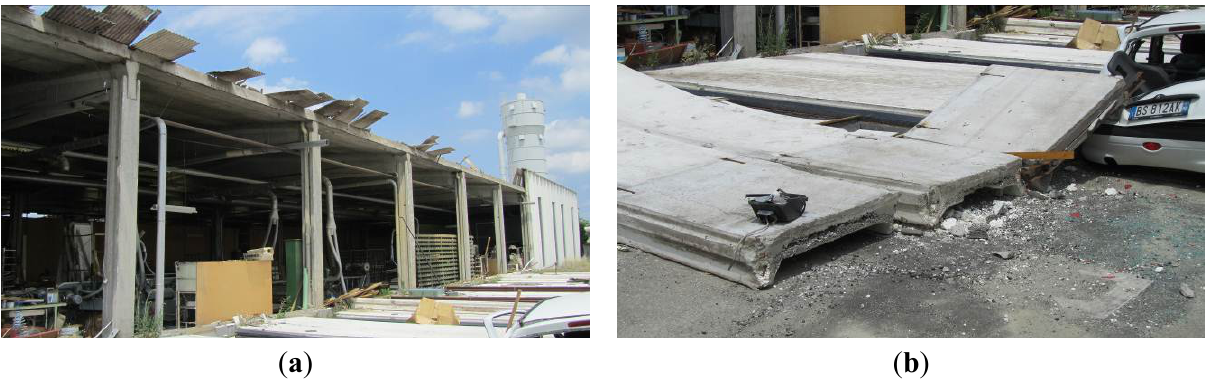
Figure 7. External view of precast reinforced concrete (RC) building with tilted façade panels: ( a ) Damaged façade; ( b ) Detail of heavy façade panels.